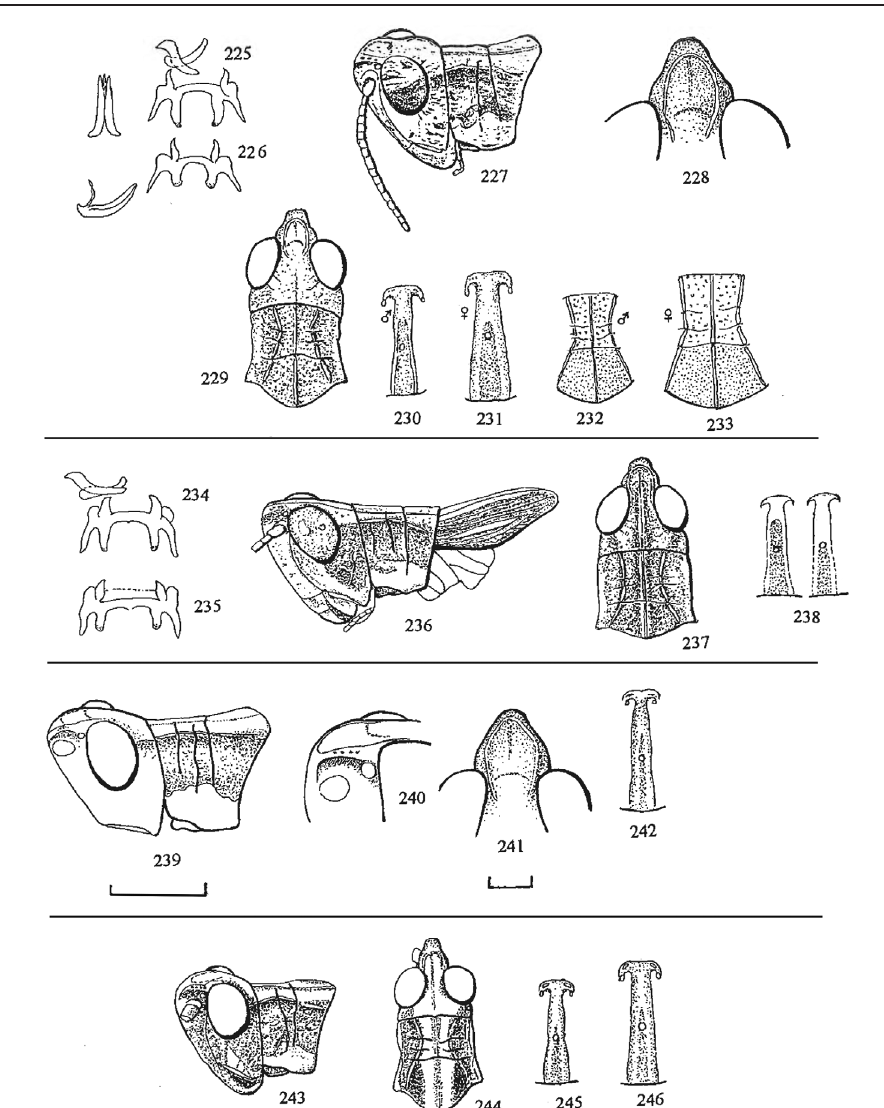
Figs 225–246. Tribe Gymnobothrini. Gymnobothrus anchietae . Figs 225–233. Gymnobothrus anchietae anchietae : 225, 226. Epiphallus (Rukwa); 227. Male oblique view head and pronotum; 228. Male dorsal view vertex; 229. Male dorsal aspect head and pronotum; 230, 231. Male, female, frontal ridges; 232, 233. Male, female pronotal discs. Figs 234–238. Gymnobothrus anchietae bounites : 234, 235. Epiphallus; 236. Male, oblique aspect head, pronotum and tegmina; 237. Dorsal aspect head and pronotum; 238. Male frontal ridge. Figs 239–242. Gymnobothrus anchietae flaviventris : 239. Male oblique view head and pronotum; 240. Oblique view vertex; 241. Dorsal view vertex; 242. Male frontal ridge. Figs 243–246. Gymnobothrus anchietae inflexus: 243. Male oblique aspect head and pronotum; 244. Same, dorsal aspect; 245. Male frontal ridge; 246. Female same. Scale lines all 1 mm: that under Fig. 239 applies to Figs 225, 226, 228, 230, 231, 234, 235, 238, 240–242, 245–246; that under Fig. 241 applies to Figs 227, 229, 232, 233, 236, 237, 239, 243,